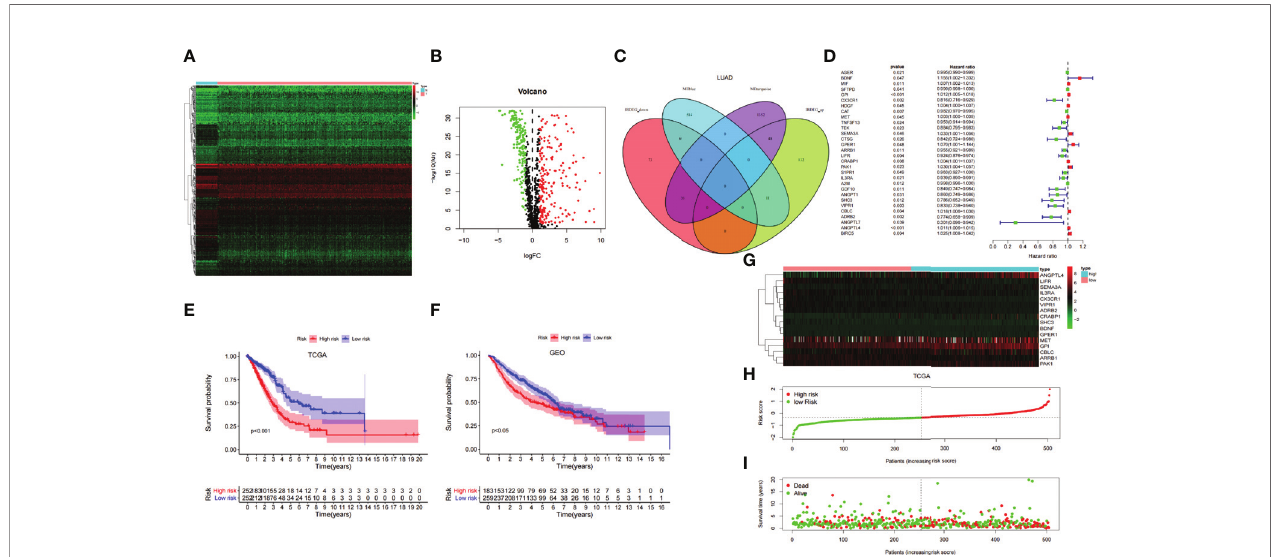
FIGURE 4 | (A) The heat map of immune-related DEGs in LUAD. (B) Volcano map of immune-related DEGs in LUAD. Green, downregulated genes; red, upregulated genes. (C) Venn diagram of the intersection genes related to both mRNAsi and immunity. (D) Univariate COX regression analysis of prognosis-related stem cell and immune-related differential genes (SCIRGs) in LUAD. (E, F) Kaplan – Meier curves show a considerable difference between the high- and the low-risk groups. (G) Heat maps of the hub genes ’ expression pattern, where the red to green means changes from high to low expression in TCGA. (H) Distribution of multi- genes signature risk score in TCGA datasets. (I) The survival status and interval of TCGA-LUAD patients.